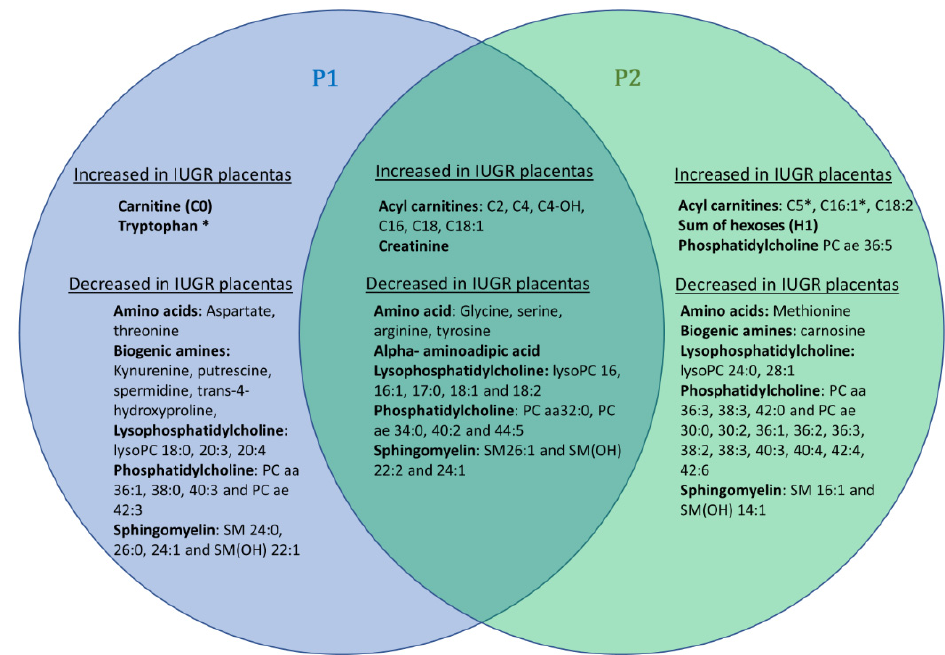
Figure 3. Venn diagram showing common discriminant metabolites in placenta P1 and/or P2 cohorts. Discriminant P1 metabolites have been drawn in a blue circle whilst important P2 metabolites have been included in a green circle. The intersection of both signatures comprises 25 metabolites, all varying in the same way in both cohorts: increased levels of 6 acyl-carnitines and creatinine and decreased levels of glycine, serine, arginine, tyrosine, alpha-aminoadipic acid, five lysophosphatidylcholine species (lysoPC), one diacyl phosphatidylcholine (PC aa 32:0) and three alkyl-acyl phosphatidylcholine (PC ae) species and 4 (hydroxy)sphingomyelin species (SM (OH) and SM, respectively). For the acylcarnitine, lysophosphatidylcholine, phosphatidylcholine and (hydroxy)sphingomyelin species, the sum of the length of the one or two acyl or acyl-alkyl groups is noted after “C”, “lysoPC”, “PC” and “SM(OH)” or “SM”, respectively, and is followed by the number of double bonds. * Indicates metabolites measured in only one cohort because they were out of range in the other cohort.